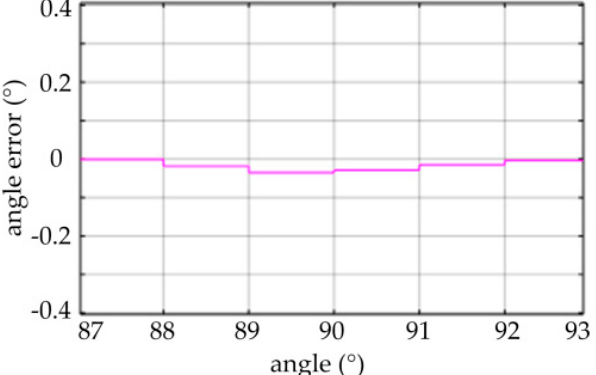
Figure 8. Angle error.